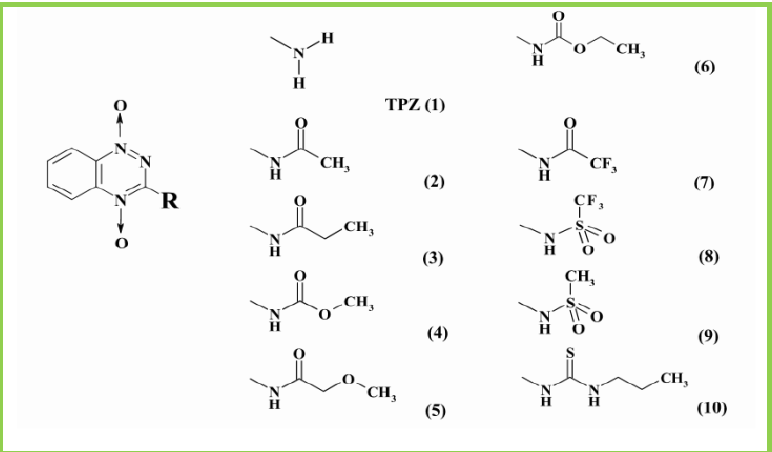
Figure 1. The formulae of 3-amino-1,2,4-benzotriazine-1,4-dioxide (tirapazamine (TPZ ( 1 ), SR4233) and its derivatives used in the current work.